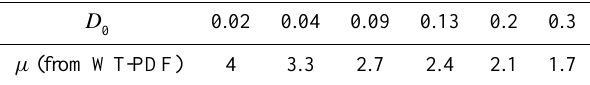
Table 1. Values of µ estimated from the WT distribution and the associated threshold values ( U x